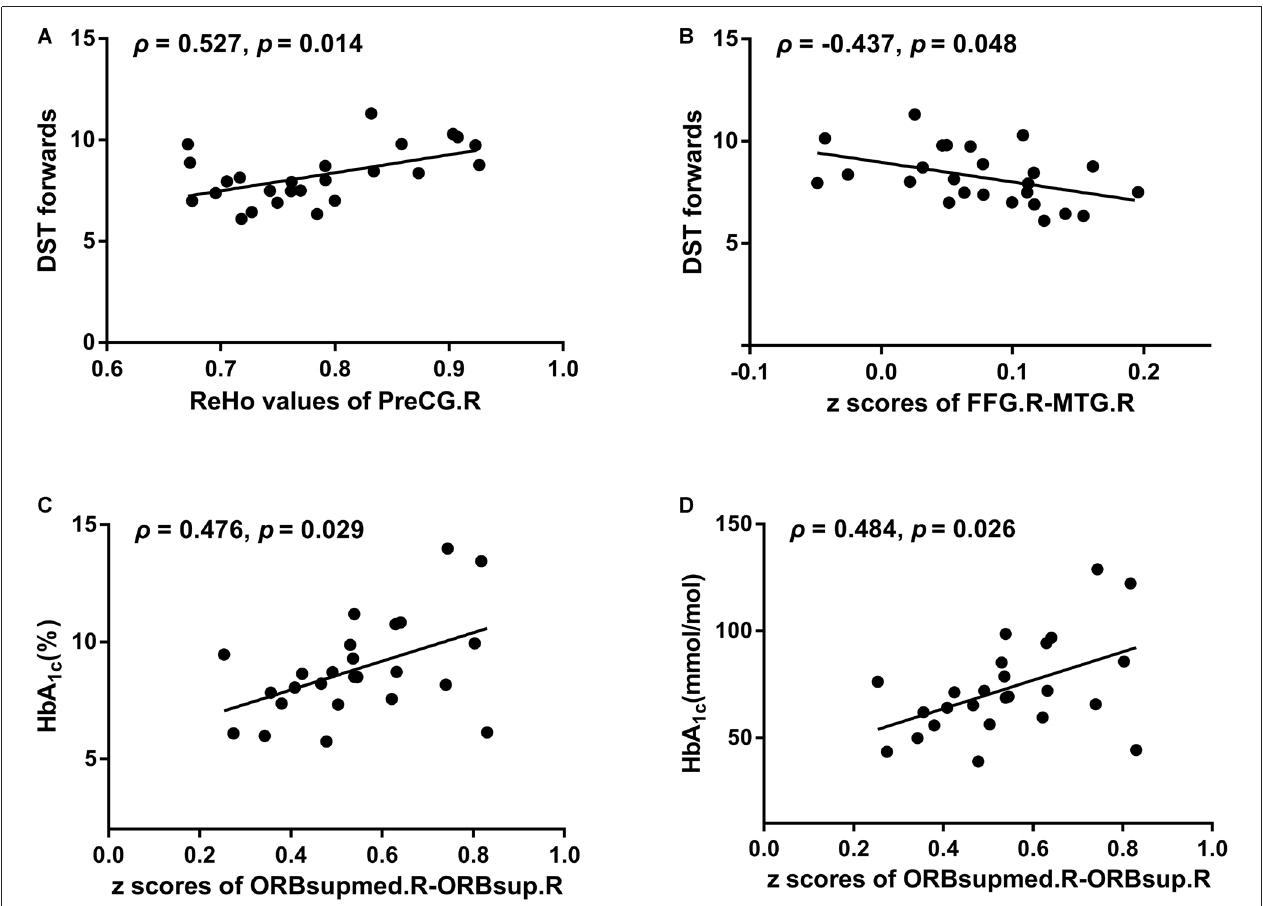
FIGURE 3 | The relationships of aberrant ReHo/FC with neuropsychological performances/diabetes-related parameters after adjustment for age, sex, education and body mass index (BMI). (A) ReHo values of PreCG.R vs. DST forwards. (B) z scores of FFG.R-MTG.R vs. DST forwards. (C) z scores of ORBsupmed.R-ORBsup.R vs. HbA 1c (%). (D) z scores of ORBsupmed.R-ORBsup.R vs. HbA 1c (mmol/mol). DST, Digital Span Test; PreCG, precentral gyrus; FFG, fusiform gyrus; MTG, middle temporal gyrus; ORBsupmed, superior frontal gyrus, medial orbital; ORBsup, superior frontal gyrus, orbital part; R, Right; L,